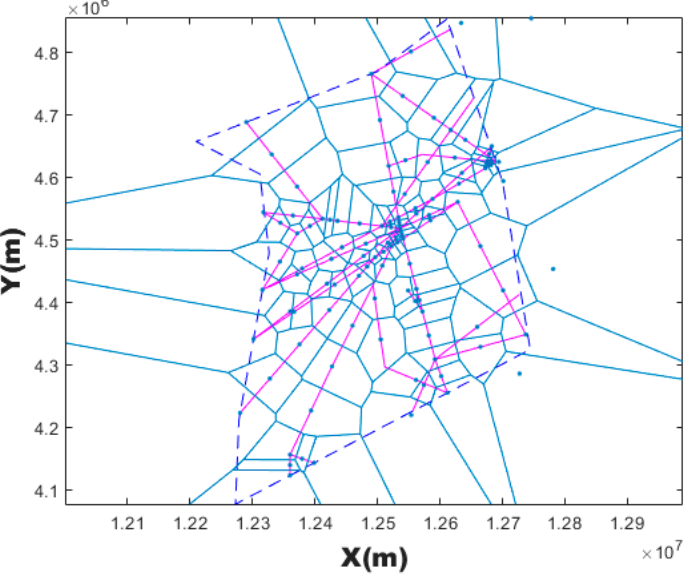
Figure 4. Seeds generated by taking a point every 30 km along the route.